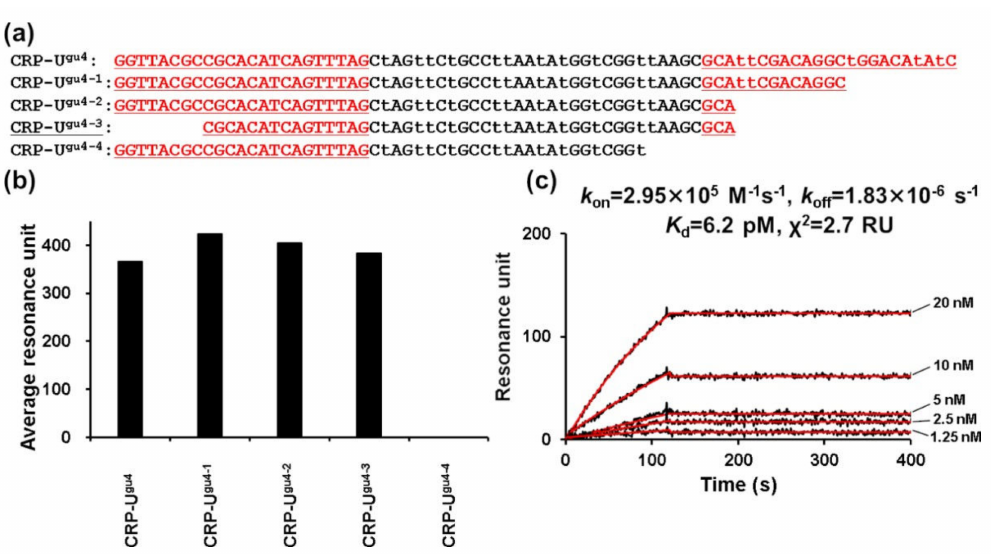
Figure 3. CRP–U gu4 truncated aptamer preparation. ( a ) Sequences of the CRP–U gu4 truncated aptamers. Sequences are aligned in the 5 (cid:48) to 3 (cid:48) direction. Underlined regions derive from the primer or primer-binding regions. The letter “t” indicates U gu . ( b ) SPR response units of the interaction between the CRP and the CRP–U gu4 truncated aptamers. Measurements were performed with multicycle kinetics, and CRP (400 nM) was injected over the respective aptamer-immobilizing sensor chips for 120 s at a flow rate of 50 µ L / min. SPR response units between 115–125 s, in the plateau region of the sensorgram curves, were averaged. ( c ) Representative SPR sensorgrams showing the interaction between the CRP and the aptamer CRP–U gu4 − 3 . Various concentrations of CRP (1.25–20.00 nM) were injected over the respective CRP-U gu4 − 3 -immobilizing sensor chip for 120 s at a flow rate of 50 µ L / min. The black line represents the measured curve, and the red line represents the fitting curve. The average of the squared di ff erences between the measured data points and the corresponding fitted values are represented as χ 2